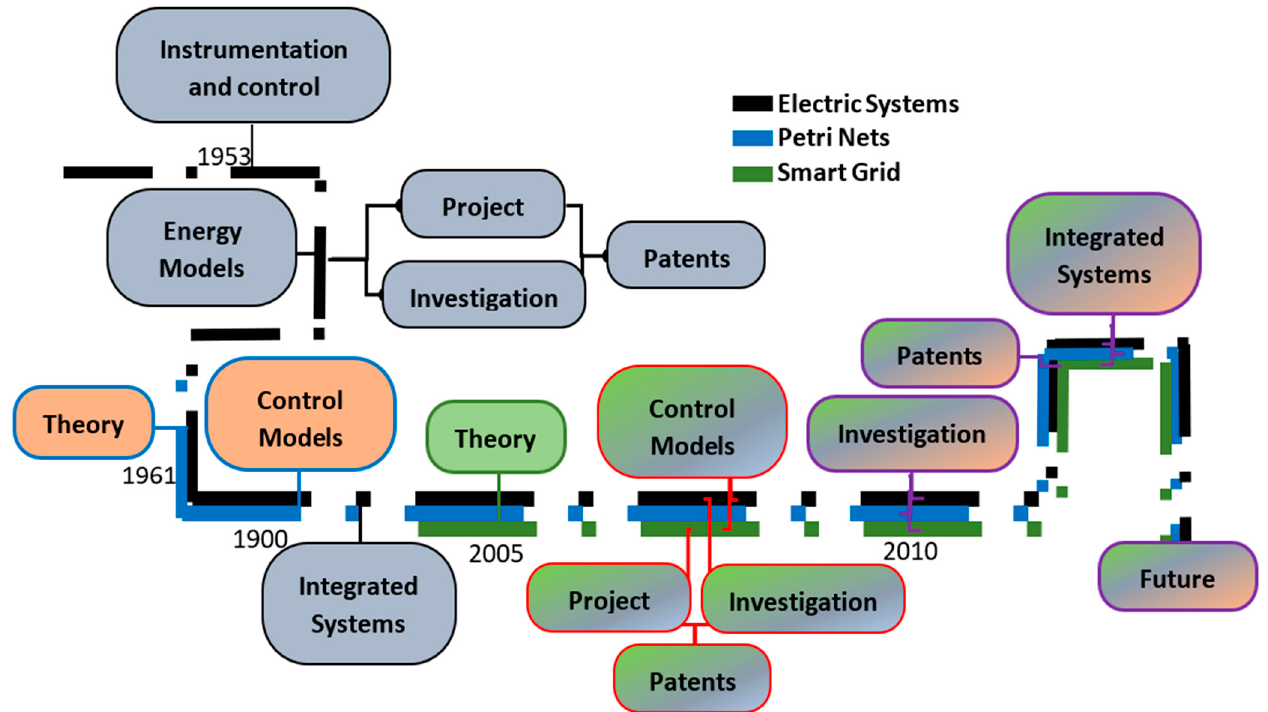
Figure 1. Flowchart to understand this review.